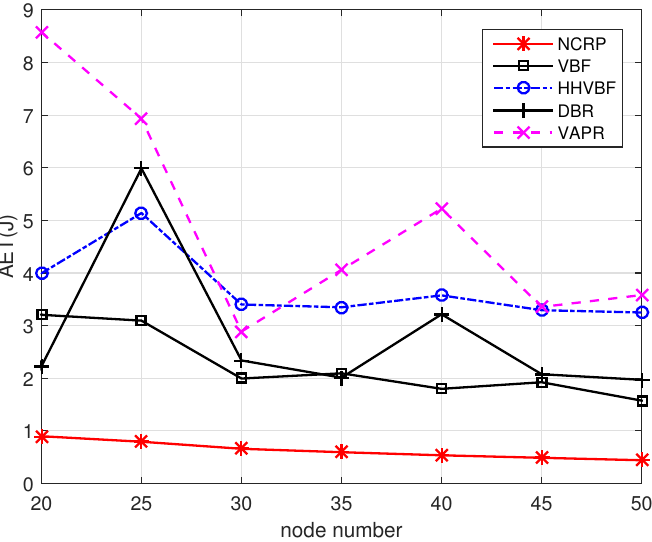
Figure 14. AET performance with varying node